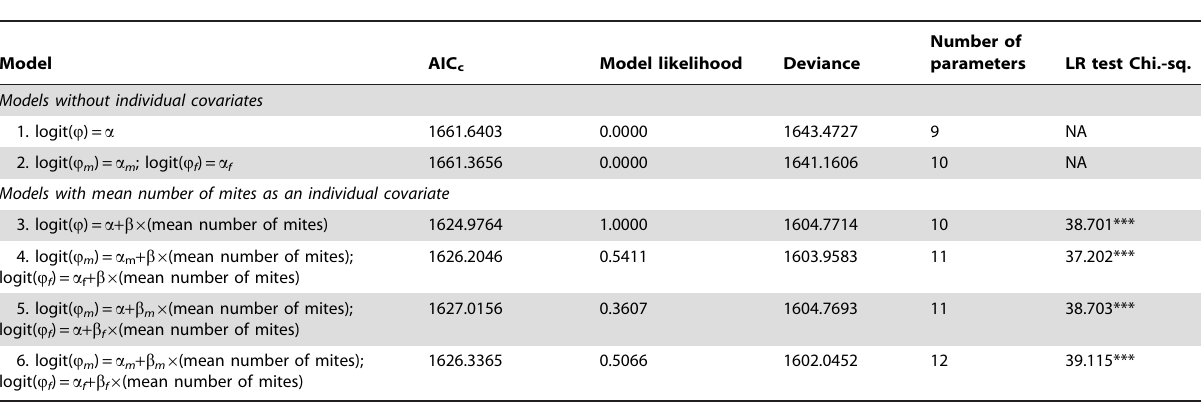
Table 1. Model selection from six candidate survival functions.